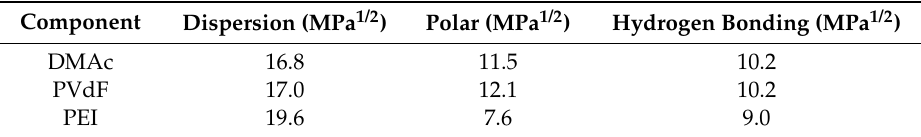
Table 1. Hansen solubility of DMAc, PVdF, and PEI